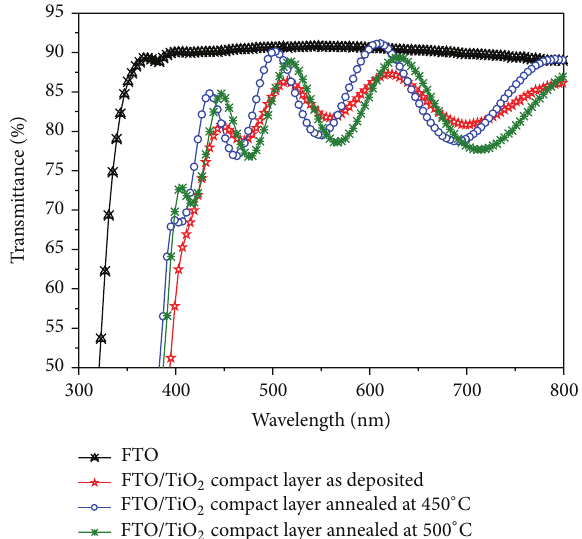
Figure 7: The optical transmittance spectra for a compact TiO 2 layer/FTO/glass.